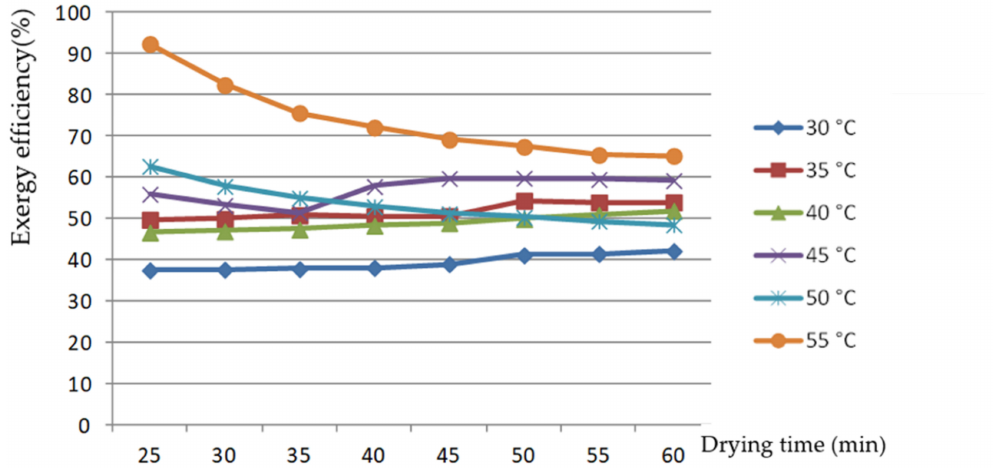
Figure 5. Changes in exergetic efficiency with drying time at different air